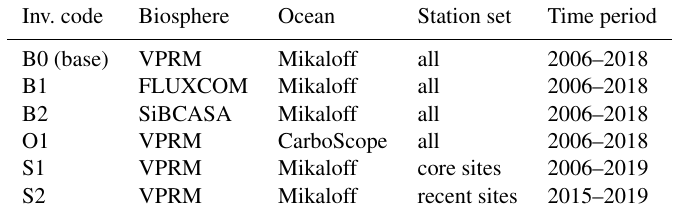
Table 2. Set-ups of the inversions.